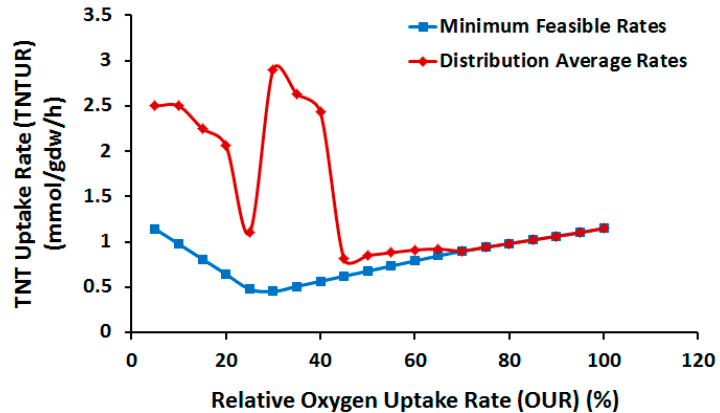
Figure 8. TNT Uptake Rate (TNTUR) as a function of oxygen uptake rate (OUR) relative to the optimal value (%). value (%).